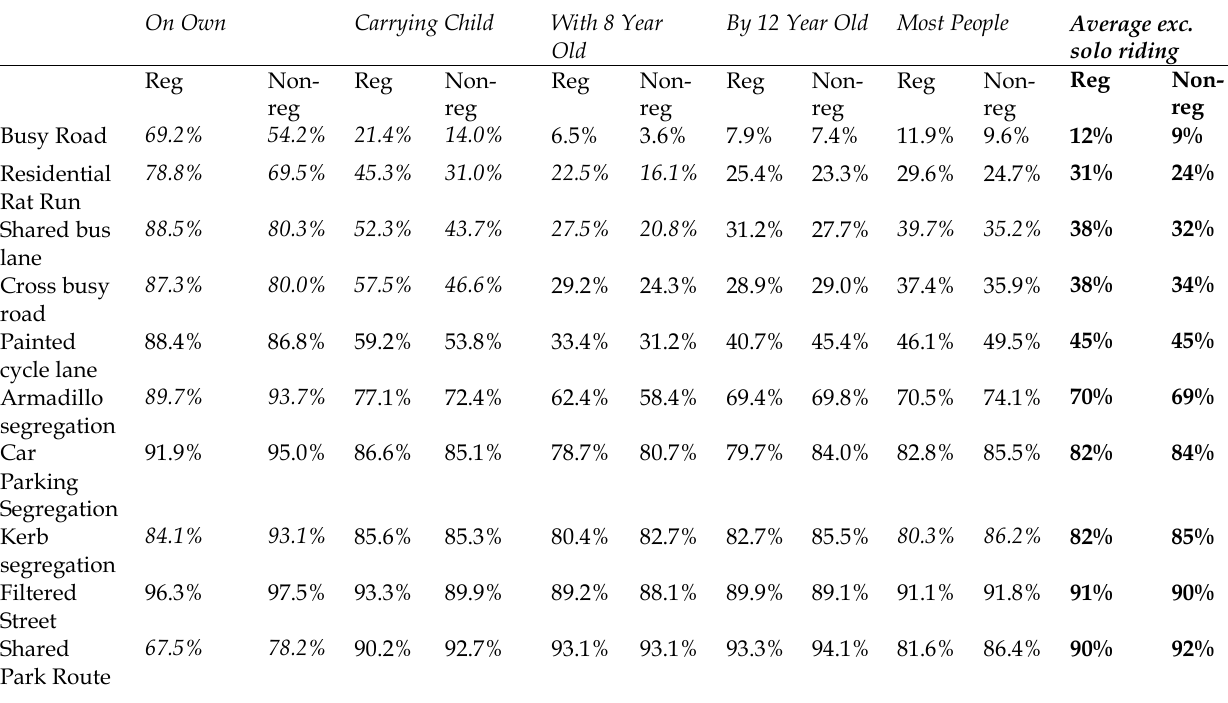
Table 3. Preferences by